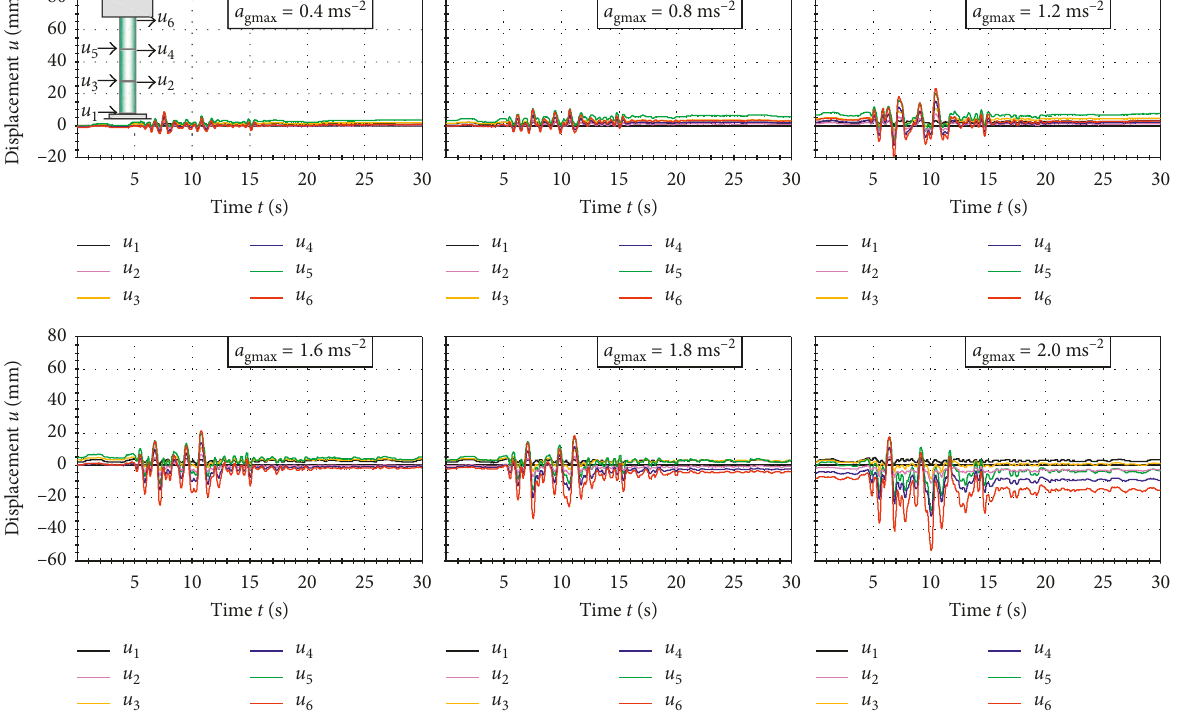
Figure 10: Horizontal displacements u 1 to u 6 of the column S3m for the Petrovac accelerogram at some a gmax